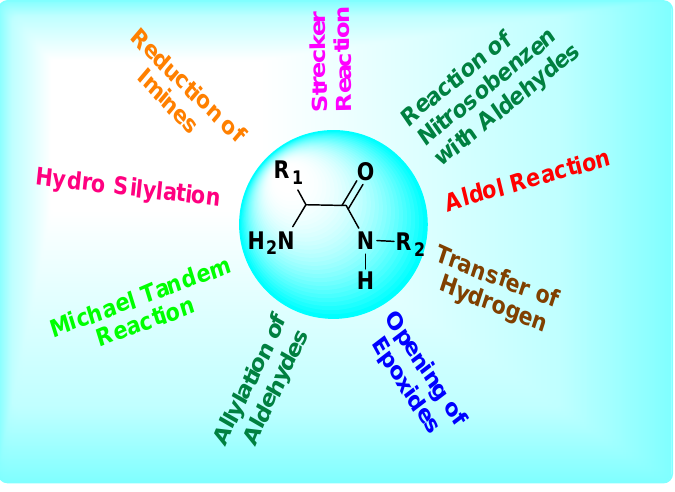
Figure 1. Catalytic efficiency of prim ary α -amino amides.